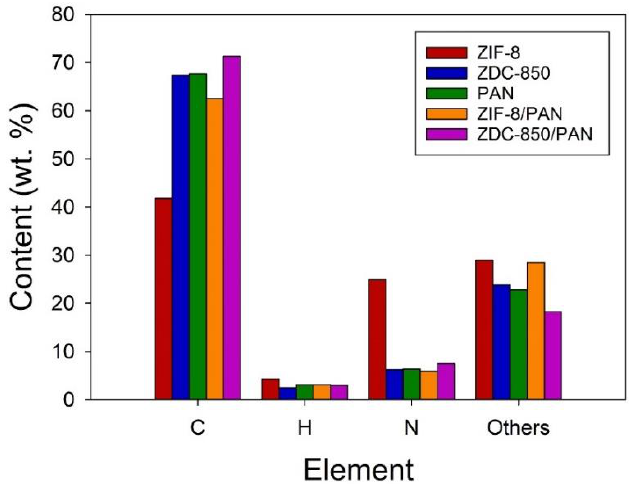
Figure 5. The weight percentage of the elements in the bulk phase of the samples obtained from the elemental analysis (EA).